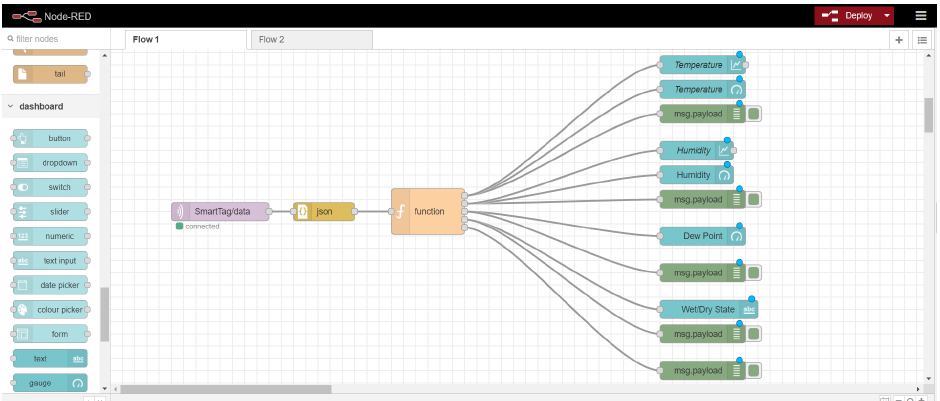
Figure 6. Node-RED flow for the user